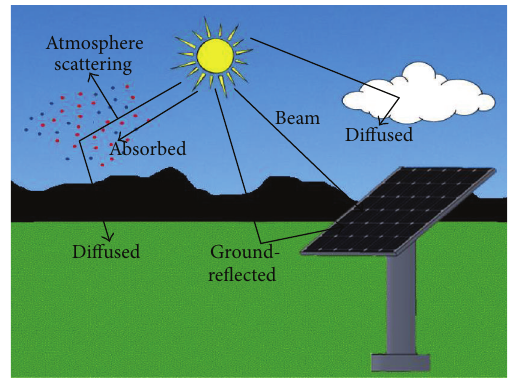
Figure 2: The three components of global solar radiation.